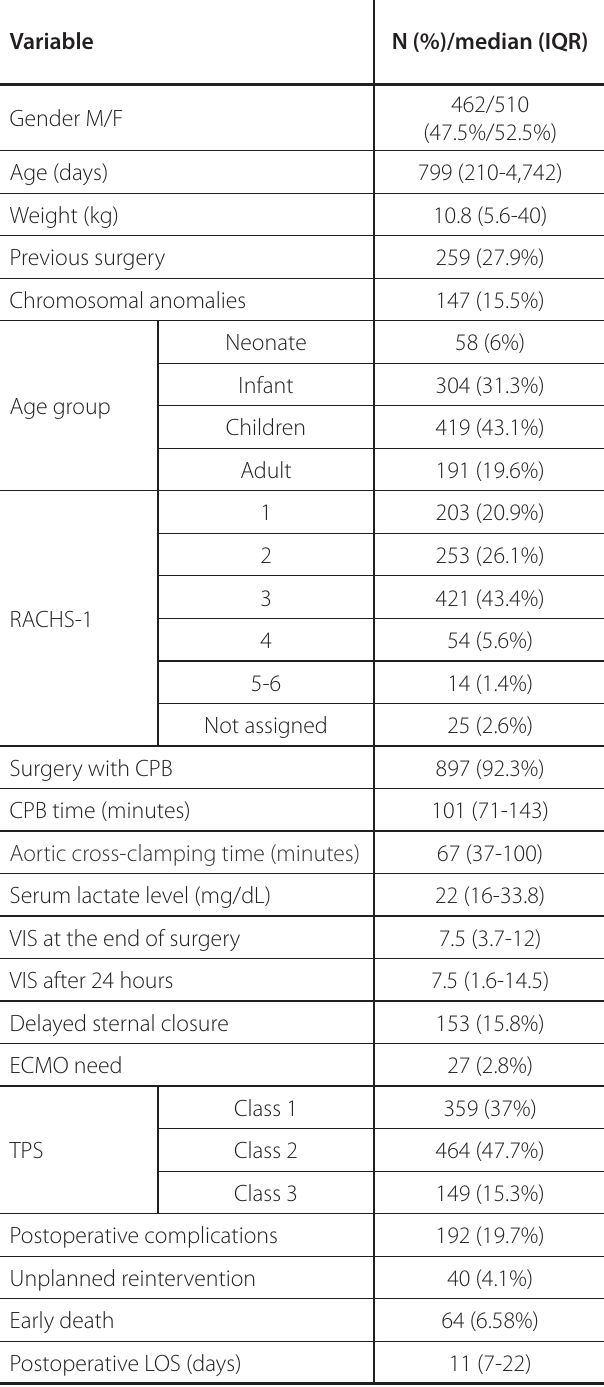
Table 1 . Demographics, patients’ characteristics, and outcomes of